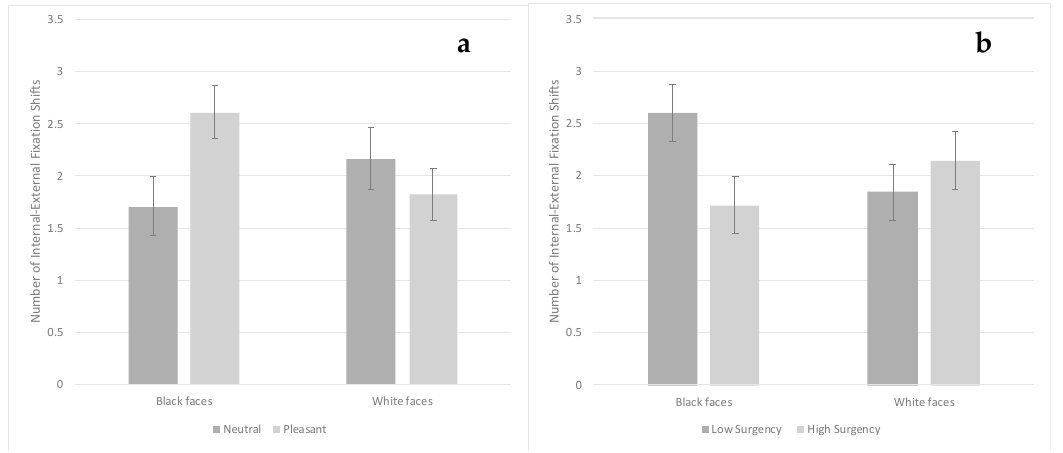
Figure 8. Number of fixation shifts between the internal and external features of the familiarized face based on face race and expression (( a )—left chart) and based on face race and infants’ surgency (( b )—right chart). Bars represent standard error.